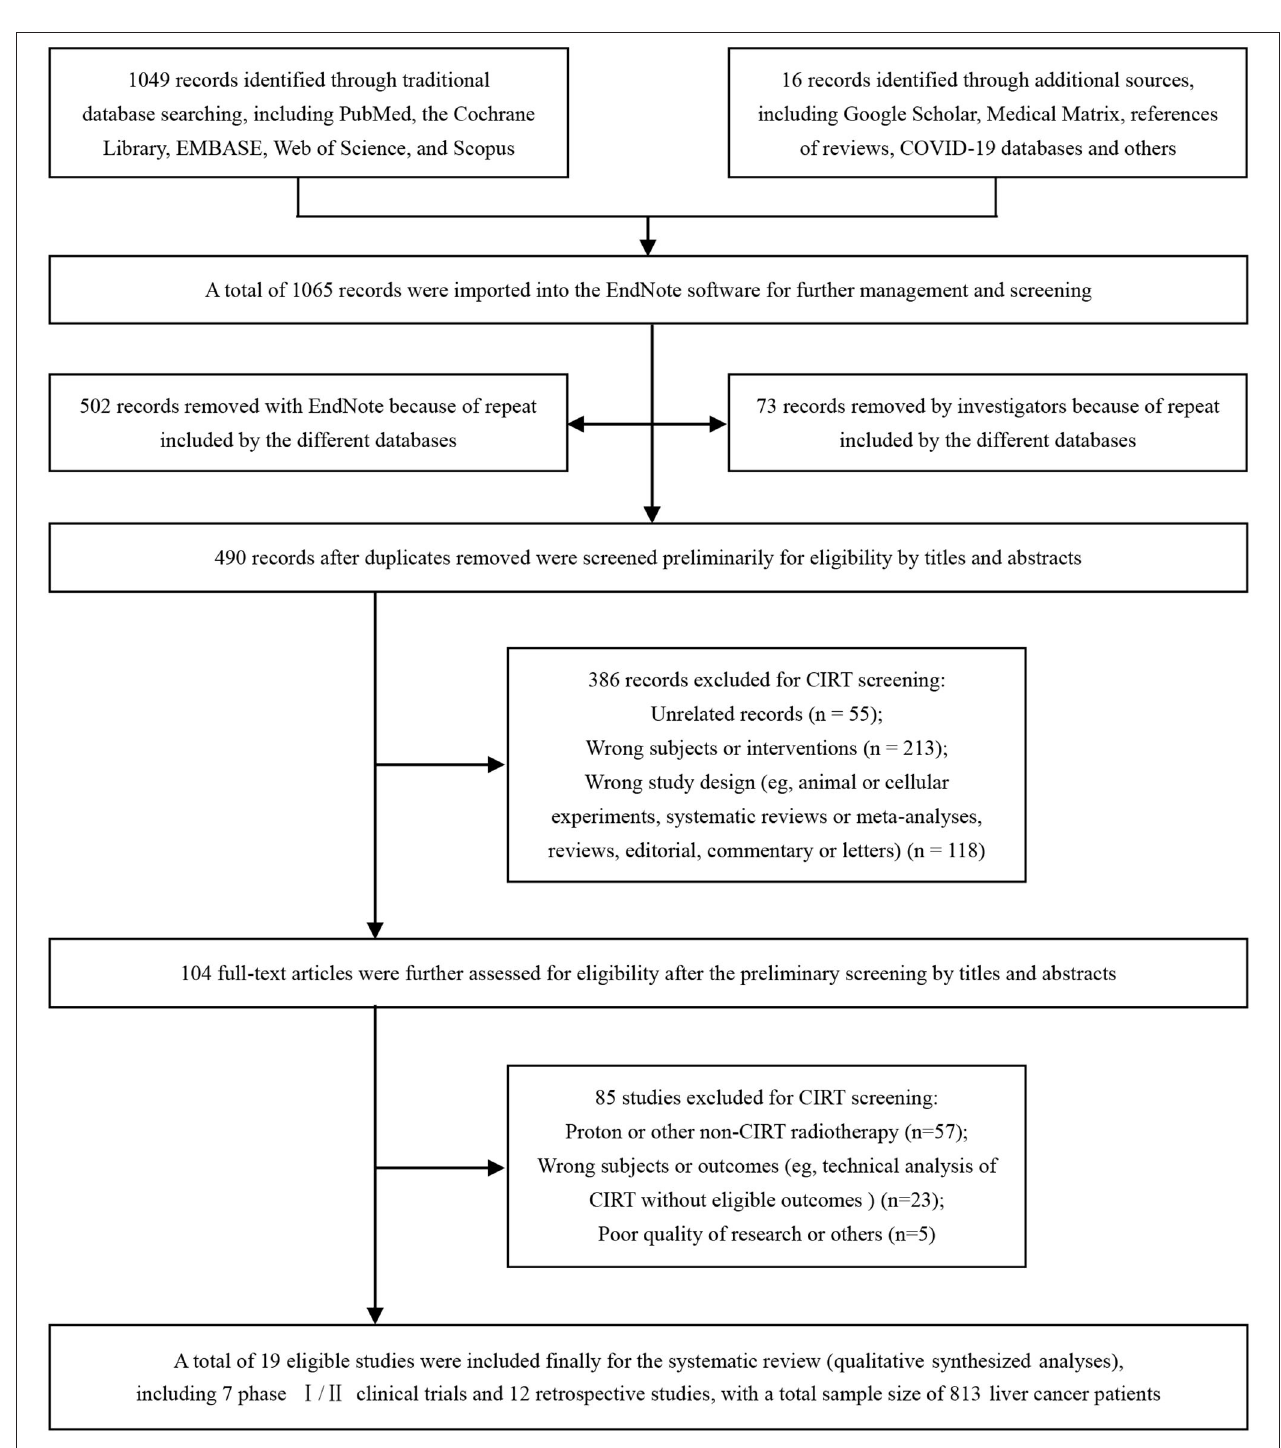
FIGURE 1 | Identification flow chart of the studies to evaluate carbon ion radiotherapy (CIRT) for liver cancer. CIRT, carbon ion radiotherapy.